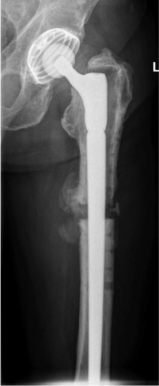
Figure 1. Anteroposterior (a.-p.) view of a 70-years old man that presented with a loosened THA. Thirty-five months before index operation, conversion of a failed osteosynthesis by a plate into a THA due to a pathologic fracture of a solitary metastasis of a renal cell carcinoma was performed (intralesional procedure with postoperative irradiation). Indication for revision of the THA was subsidence due to the non-integration of the cementless stem and instability related